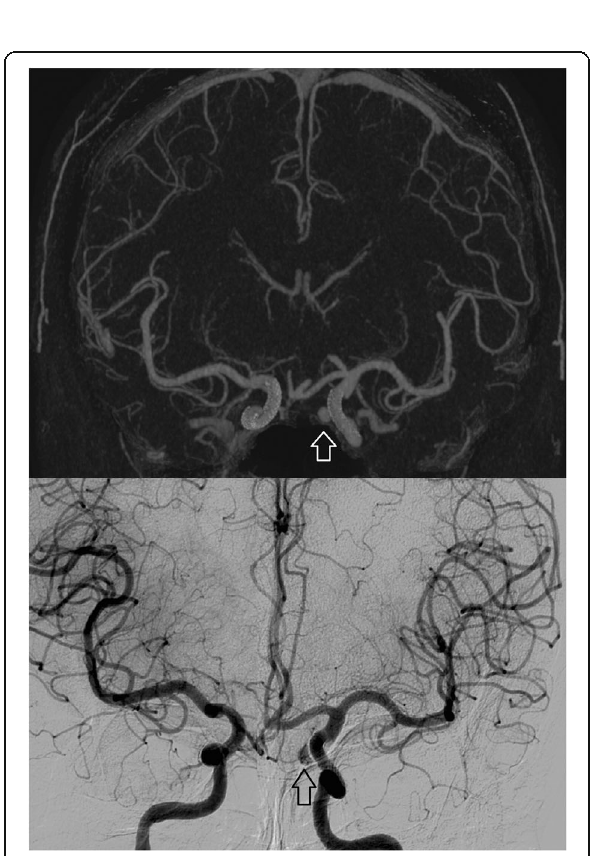
Fig. 3 Fifty-seven-year-old female with flow diverter placement for treatment of internal carotid artery (ICA) aneurysms on both sides. At follow-up, occlusion of the right ICA aneurysm and residual contrast filling of the left ICA aneurysm (arrows) was seen with full consistency between UHR subtraction CTA (top) and conventional angiography